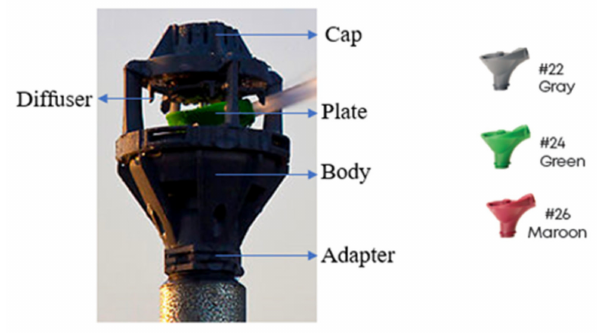
Figure 1. Components of the Nelson R33 rotating